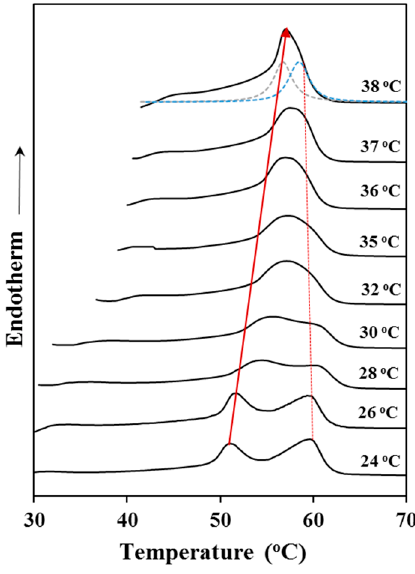
Figure 4. DSC heating runs of P4HB previously crystallized at the indicated temperatures.